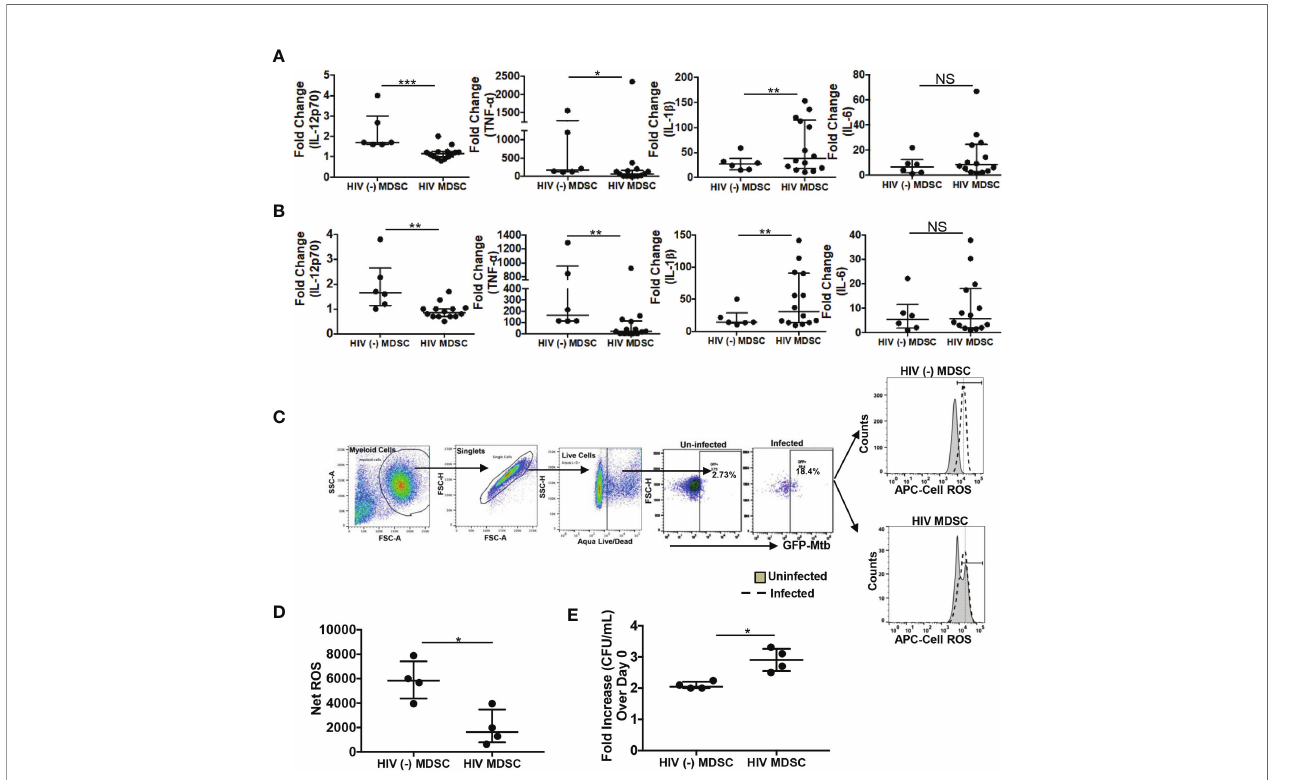
FIGURE 1 | Suppressed innate immunity of HIV MDSC in response to M tuberculosis . PBMC from HIV (-) and HIV (+) donors on cART and with virologic suppression was surface stained with anti-CD -11b, -33, -14 and HLA DR antibodies. CD11b + CD33 + CD14 + HLA DR -/lo MDSC were isolated by fl ow cytometry and named as HIV (-) MDSC and HIV MDSC, respectively. (A, B) Cells were either infected with M tuberculosis (A) or cultured with M tuberculosis whole cell lysate (B) . The amount of cytokines were measured in the culture supernatants and fold change was calculated as Quantity in presence of M tuberculosis /Quantity in absence of M tuberculosis . (C, D) MDSC were infected with GFP expressing M tuberculosis (Mtb-GFP) at multiplicity of infection (MOI) 1:5 for 2-hrs. During last 30-mins of infection 1 m M of CellROX deep read reagents was added and subsequently stained with aqua fl uorescent LIVE/DEAD stain. Expression of ROS (CellROS) in Mtb-GFP+ Live cells was determined by fl ow cytometry (MFI, Mean Fluorescence Intensity). Net ROS expression was calculated as in Materials and Methods. Representative fl ow cytometry plot of one HIV (-) MDSC and HIV MDSC donor is shown; vertical line is median. (E) MDSC cells were infected with M tuberculosis at MOI of 1:5 for 3-hrs, washed with PBS to remove extracellular bacteria, M tuberculosis growth (colony forming units (CFU)/ml) was determined in the cellular lysates at day-0 and day-5 post-infection. The fold increase in intracellular bacterial replication was measured as CFU/ml at Day-0/CFU/ml at Day-5. For (A, B, D, E) , each dot representing an individual donor include observations from 25 th to 75 th percentile; the horizontal line represents the median value. *p < 0.05, **p < 0.005, ***p < 0.0005. NS, Non Signi fi